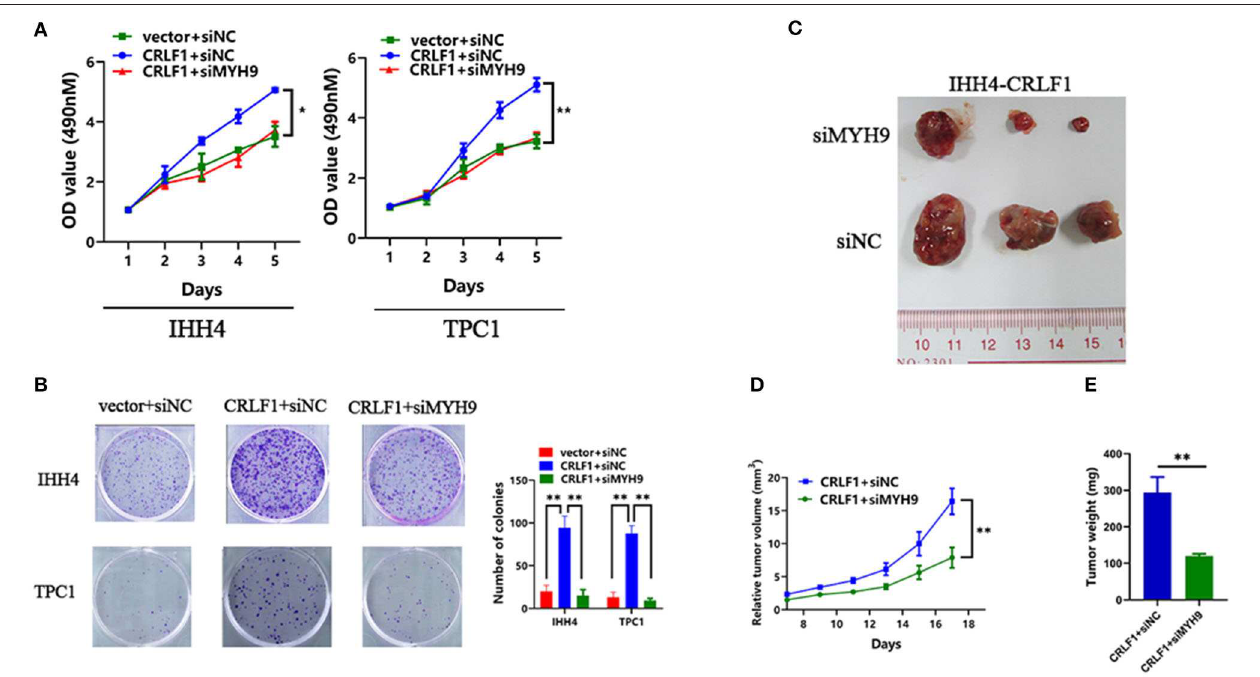
FIGURE 2 | Effects of MYH9 knockdown on CRLF1-induced growth of PTC cells. (A) MYH9 knockdown significantly alleviated the effects CRLF1 on cell viability in IHH4 and TPC1 cells. Data are presented as the mean ± SD. (B) MYH9 knockdown significantly reversed the effects of CRLF1 on colony formation in IHH4 and TPC1 cells. Data are presented as the mean ± SD. (C) Three representative tumors from siMYH9- and siNC-transfected IHH4 cells overexpressing CRLF1 (IHH4-CRLF1) in nude mice. (D) Tumor growth curves of siMYH9-transfected IHH4 cells overexpressing CRLF1in nude mice compared with those of siNC-transfected control cells. Data are presented as the mean ± SD. (E) Histogram showing the mean tumor weights from the CRLF1 + siMYH9 group and the CRLF1 + siNC group. Data are presented as the mean ± SD. Significant differences are indicated as follows: * P < 0.05 and ** P < 0.01.